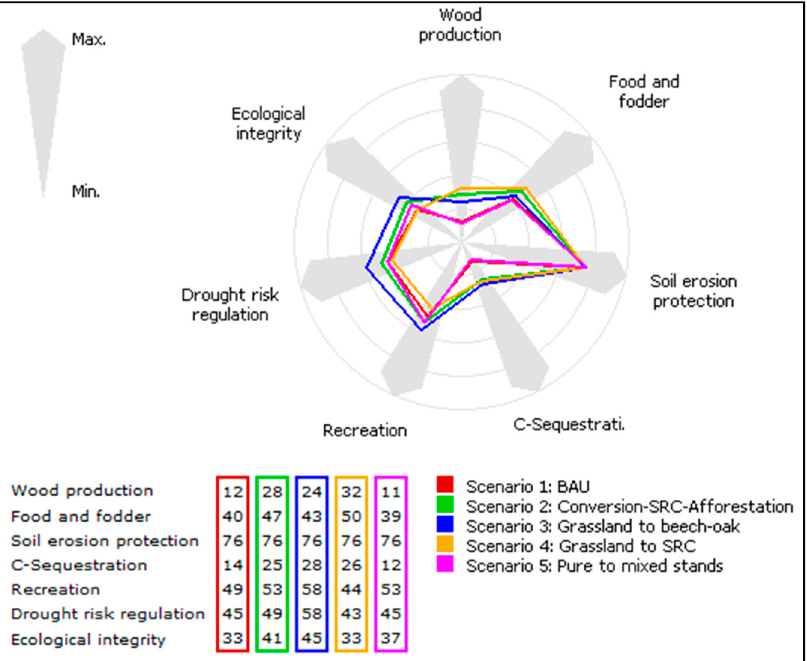
Figure 10. Comparative analysis of the five scenarios regarding seven ecosystem